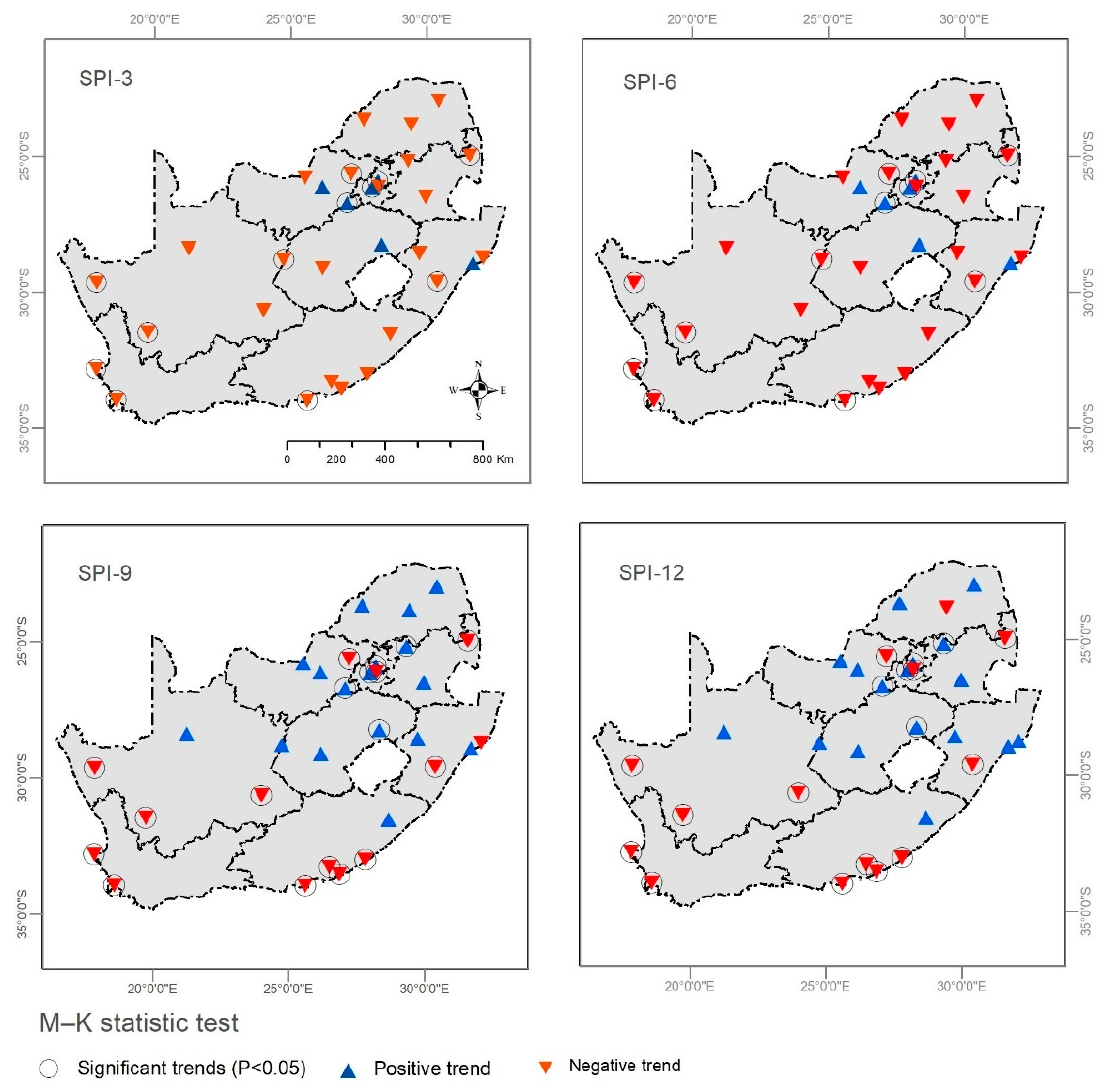
Figure 4. Drought (SPI) trend between 2002 and 2021 in South Africa on different time scales: 3 months; 6 months; 9 months; and 12 months. Table 4. Detailed trend of drought at the studied stations (2002–2021) based on MK test and Sen’s slope estimator.